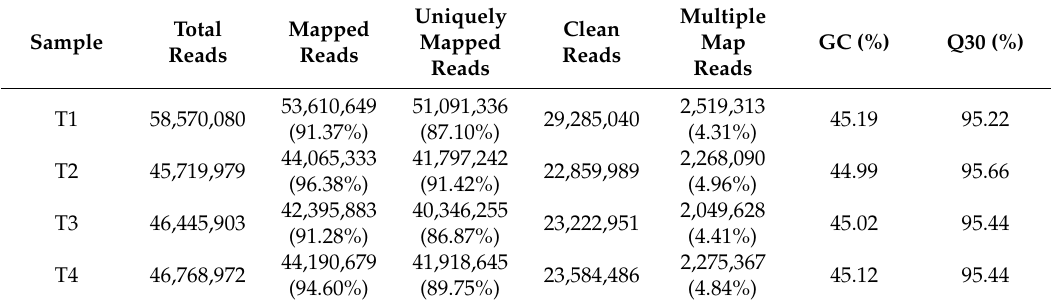
Table 1. Summary of RNA-seq data and reads mapping of cotton genotypes under nitrogen starvation and resupply